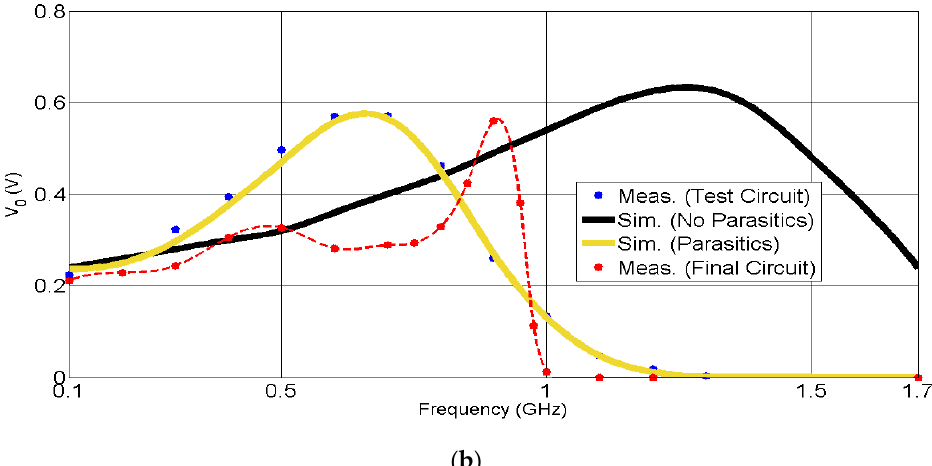
Figure 14. Test circuit with the parasitic elements modeling ( a ), and a comparison between measurement and simulation ( b ). The measurement of the response in the final circuit appears marked in red.